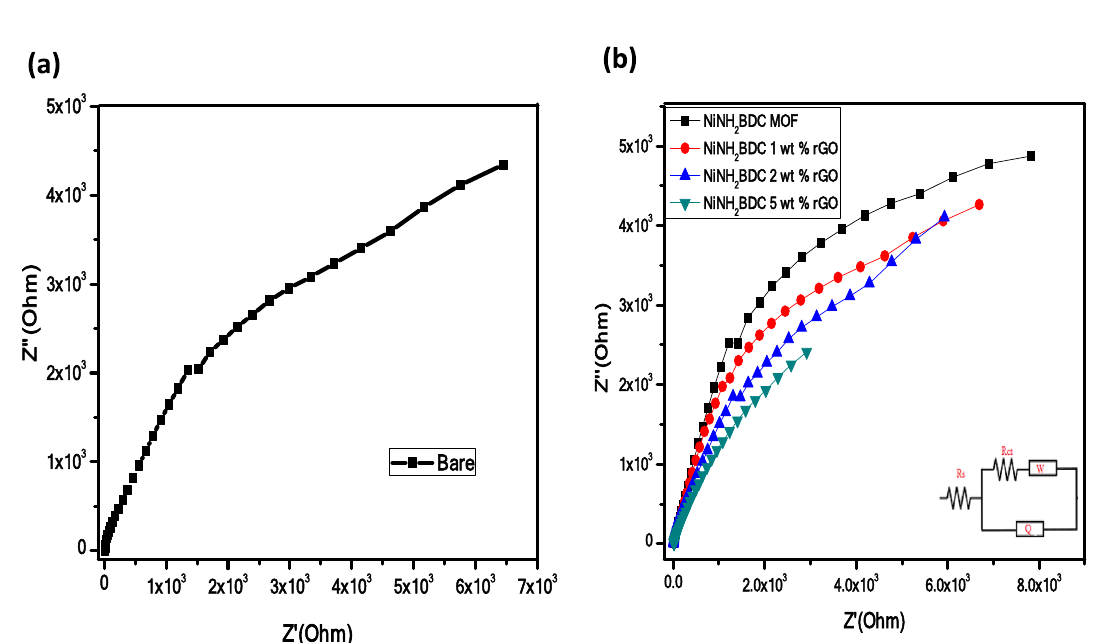
Figure 10. Nyquist plot ( a ) Bare and ( b ) NiNH 2 BDC MOF/1, 2, 5 wt% reduced graphitic carbon hybrids in 3 M CH 3 OH/1 M NaOH solution at oxidation potential 0.699